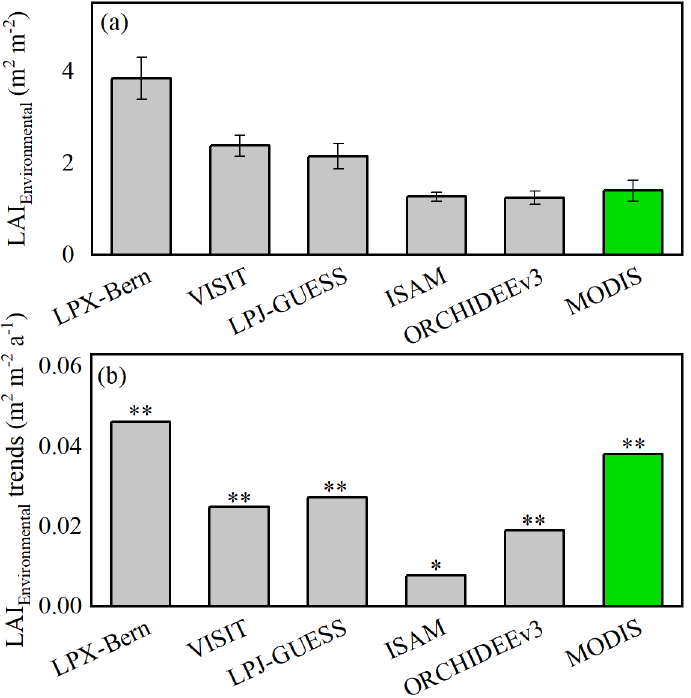
Figure 4. ( a ) Average environmental-induced LAIs based on the Scenario S2 from TRENDY project and ( b ) interannual trends of those LAIs in the Loess Plateau during the period between 2000 and 2019. * represents P < 0.05; ** represents P < 0.01.